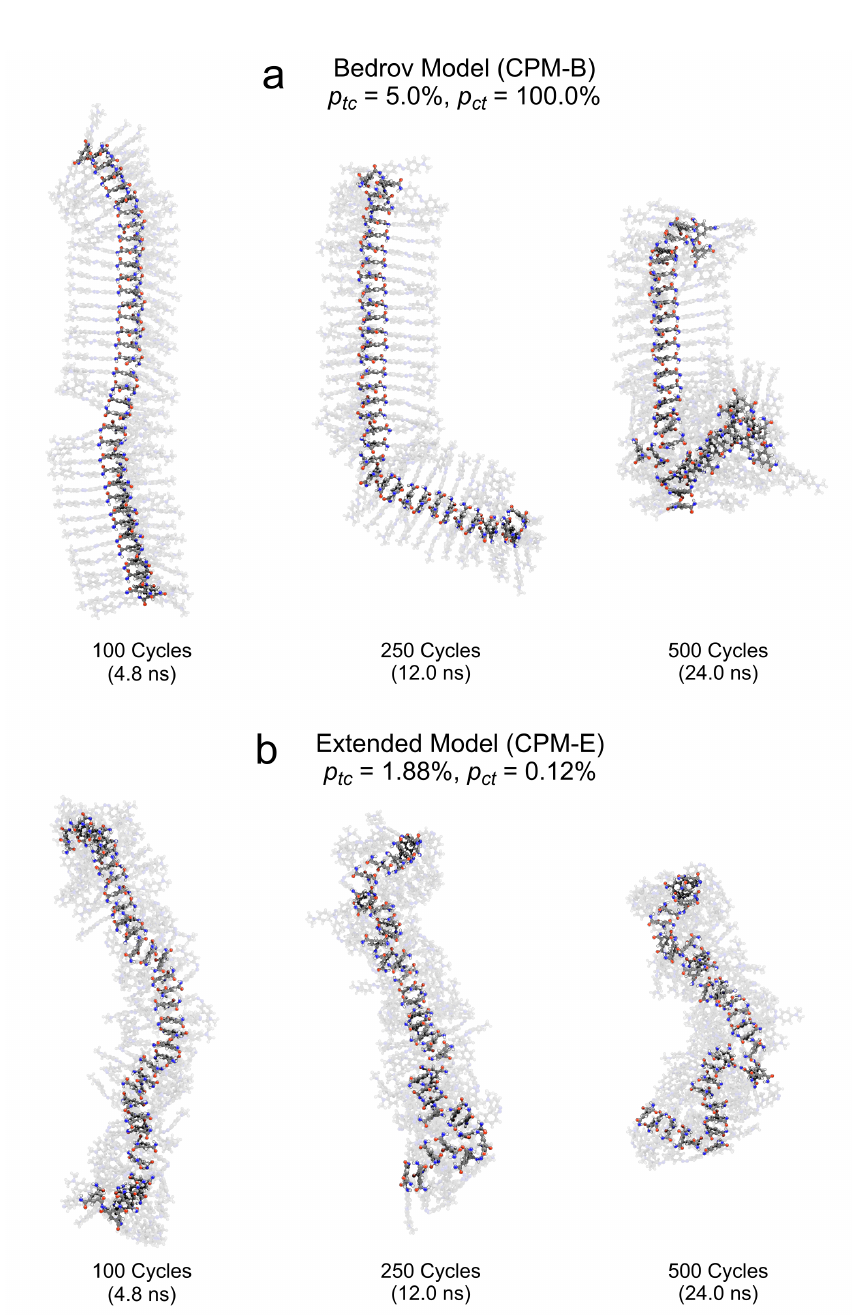
Figure 6. Simulation snapshots of the TrisAzo stack throughout the application of the cyclic photoi- somerization model. The images illustrate the time evolution of the induced structural changes in the TrisAzo stacks in the ( a ) CPM-B and ( b ) CPM-E approach. The clusters are shown at an early stage (100 cycles), at half time (250 cycles), and at the end of the simulation runs (500 cycles). The BTA groups are highlighted for better visibility. The visualizations are created using the 3D graphics software Blender [49], the plugin BlendMol [50], and the MD visualization tool VMD